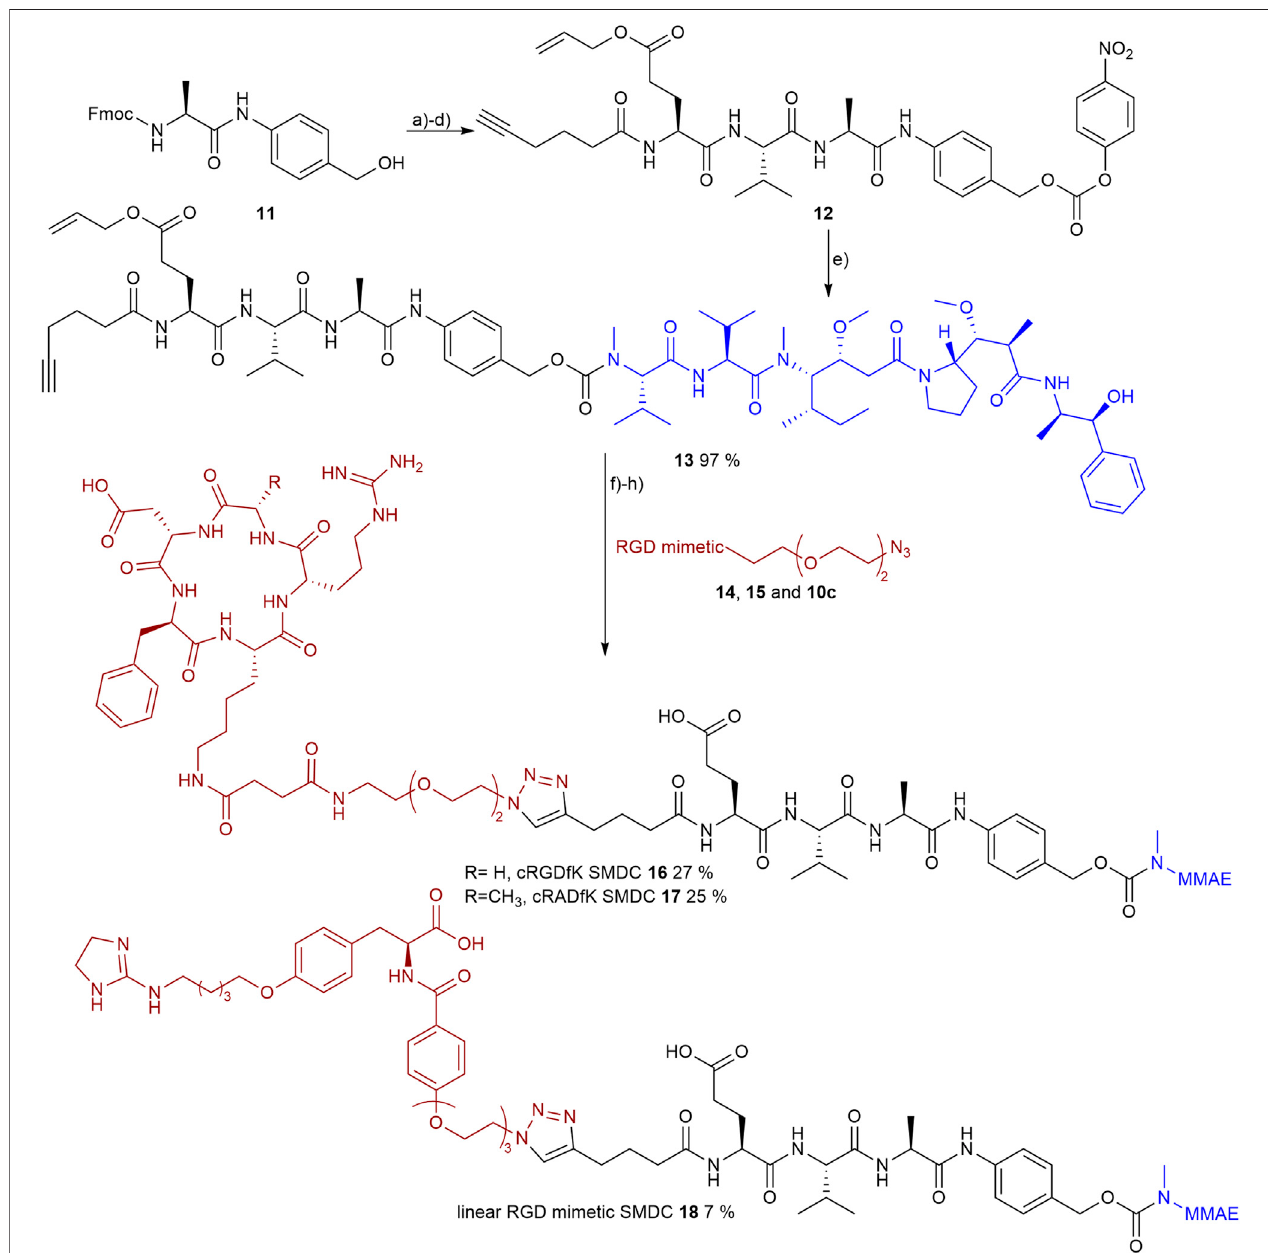
FIGURE 10 | Synthesis of the RGD or RAD containing SMDC 14-15 and 10c as RGD mimetics and MMAE as payloads. Reagents and conditions: a) pyridine, DCM, 2 days, RT; b) SPPS (1. Oxyma, DIC, DMF; 2. 20 % piperidine in DMF); c) TFA, DCM, RT; d) bis( para -nitrophenyl) carbonate, DIPEA, DMF, RT; e) MMAE, HOBt, pyridine, DMF, RT; f) TFA, TIPS, MPW, o.n., RT; g) CuSO 4 , Na-ascorbate, DMF, water, o.n., RT; and h) Pd (PPh 3 ) 4 , morpholine, DMF, water,